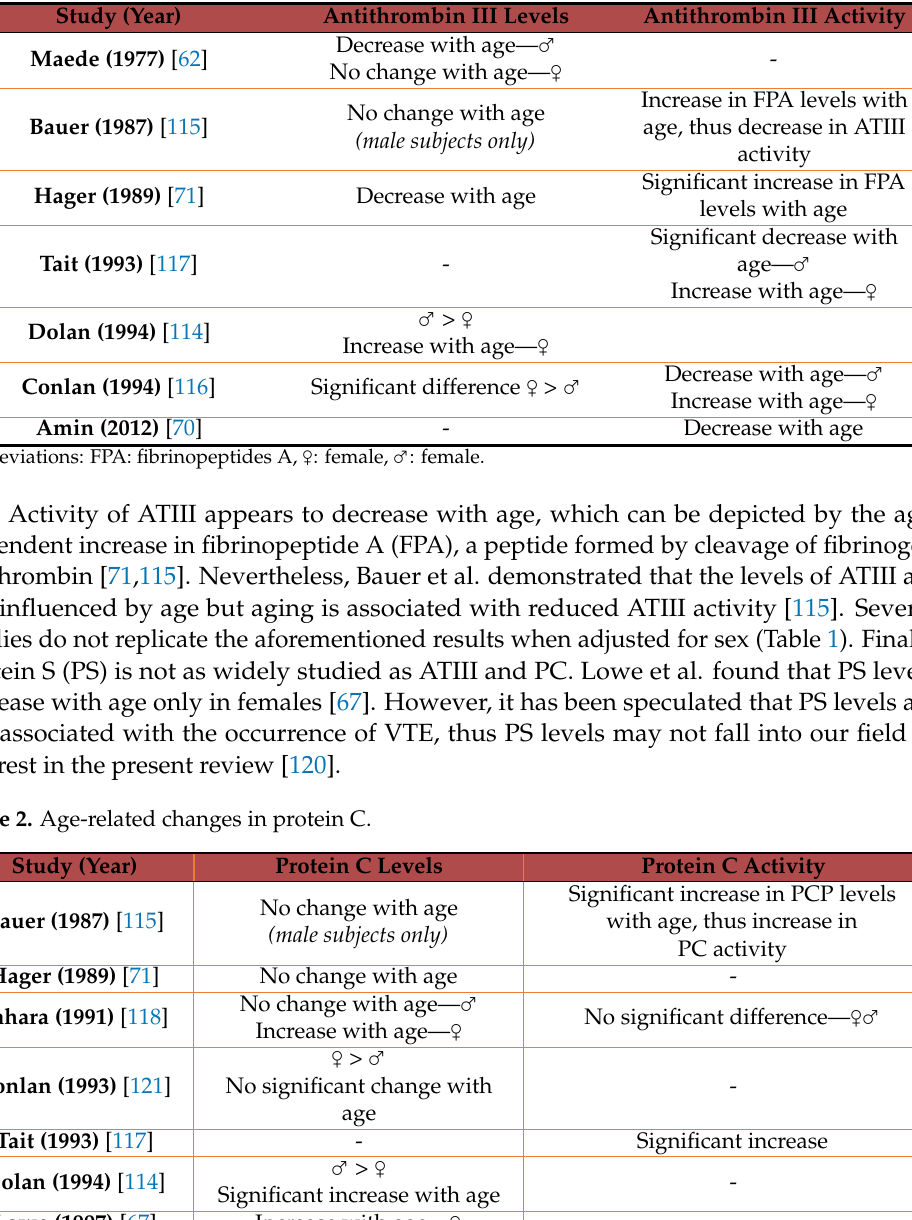
Table 1. Age-related changes in antithrombin III.